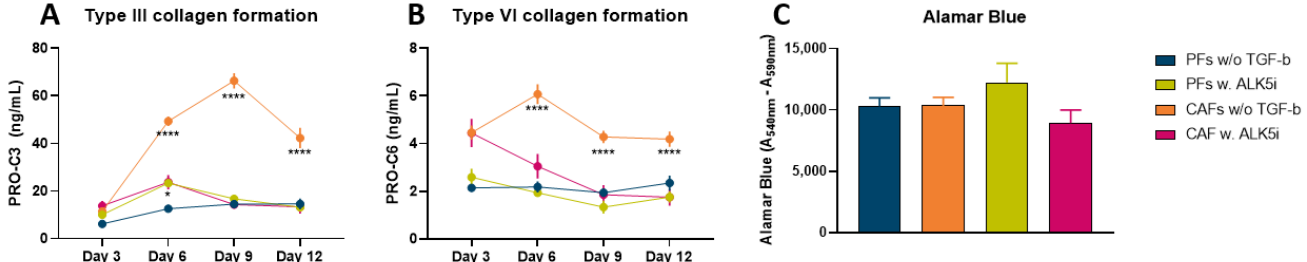
Figure 3. Fibrotic potential and metabolic activity in quiescent pancreatic fibroblasts (PFs) and pan- creatic cancer-associated fibroblasts (CAFs) treated with the TGF-ß1 inhibitor activin receptor-ki- nase 5 inhibitor (ALK5i). PRO-C3 ( A ) and PRO-C6 ( B ) were measured in supernatant from PFs with- out TGF-ß1, PFs treated with ALK5i, CAFs without TGF-ß1 and CAFs with ALK5i on day 3, 6, 9 and 12 after initiation of experiment. ( C ) On day 12 metabolic activity was assessed using Alamar Blue.